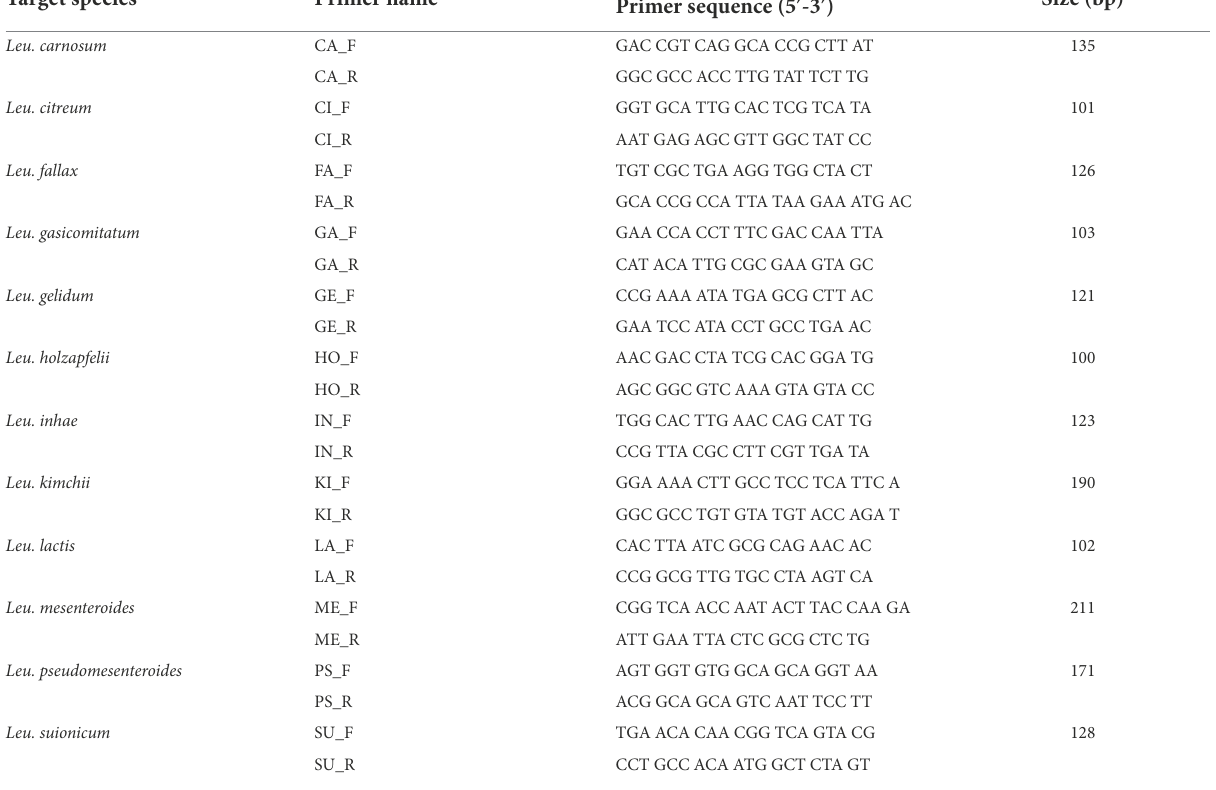
TABLE 2 Twelve Leuconostoc species-specific primer pairs used in this study.